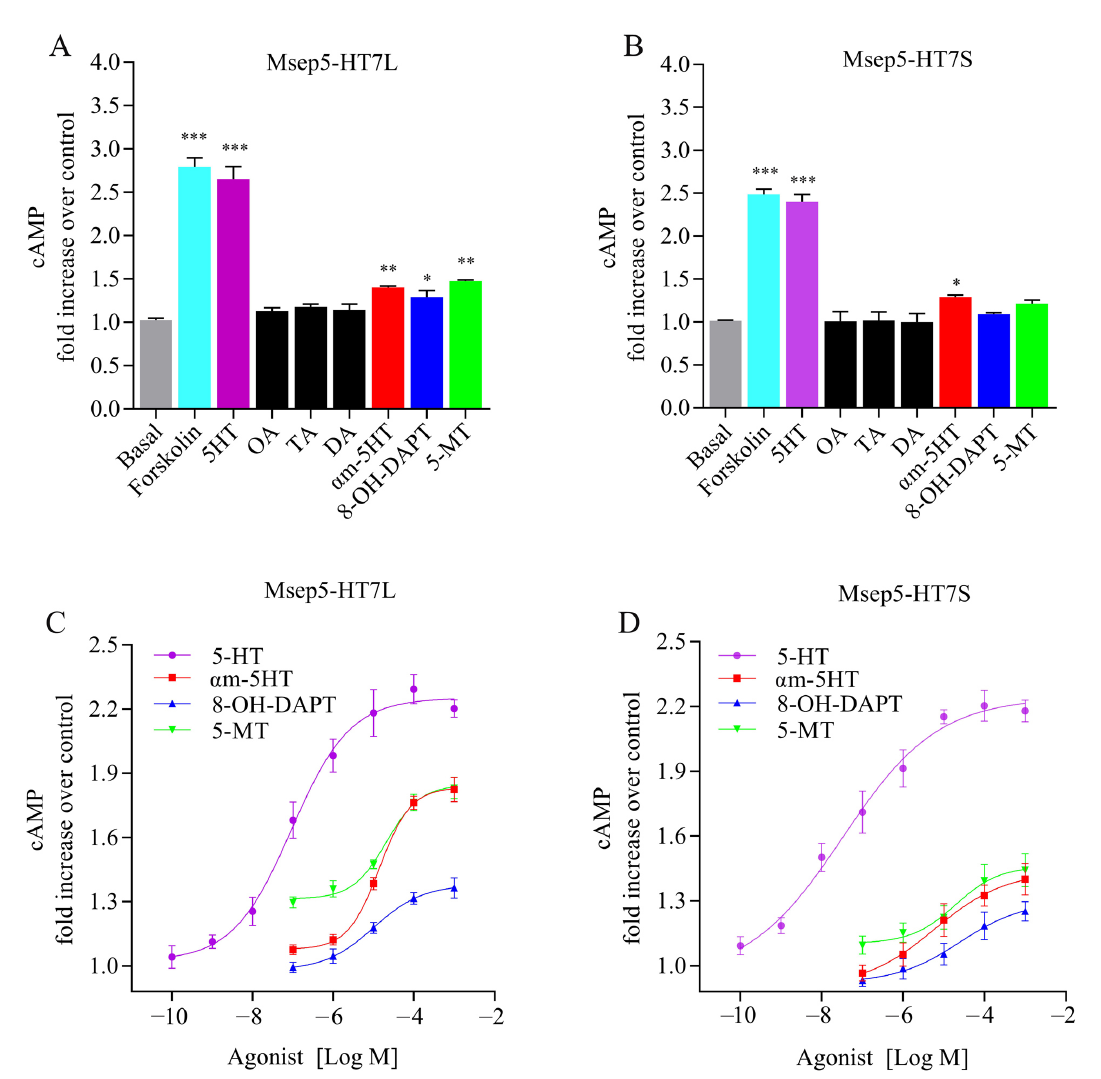
Figure 3. Effects of biogenic amines and agonists on intracellular cAMP levels in HEK293 cells Figure 3 . expressing Msep5-HT7L ( A , C ) and Msep5-HT7S receptors ( B , D ). Results are presented as fold increase of cAMP levels relative to transfected cells treated with only DPBS buffer, defined as the basal level and normalized as 1. For ( A , B ), the concentration of biogenic amines and various synthetic